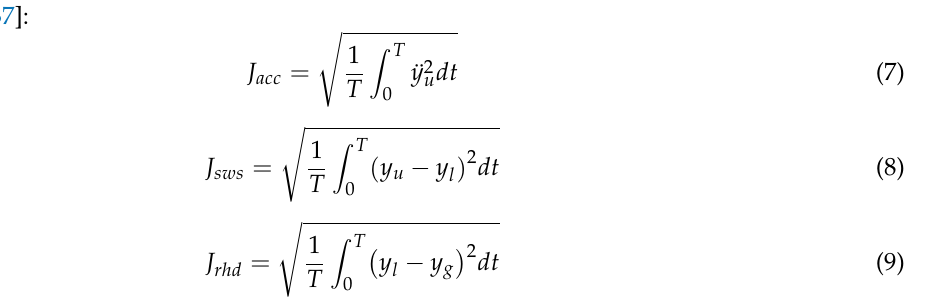
Figure 14. FRFs obtained from the MDOF model without and with TMDIs for case 3.